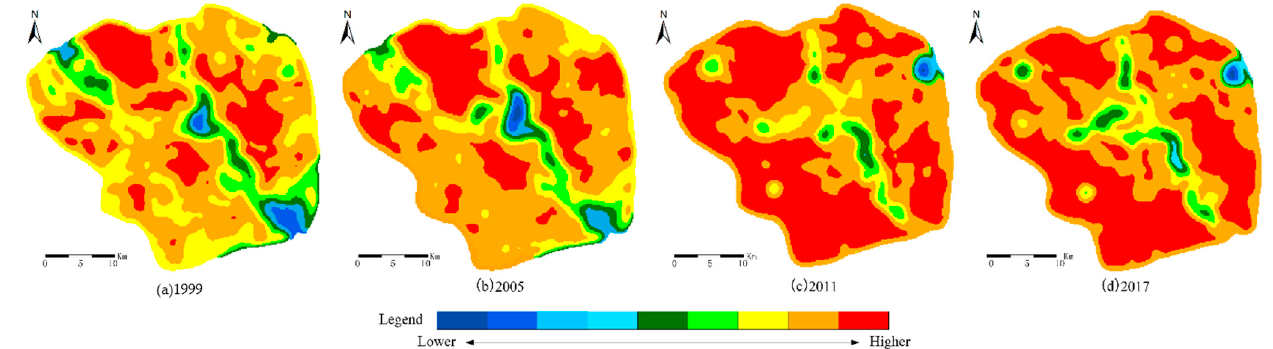
Figure 6. The spatial correlation of urban density resilience of Mianyang.